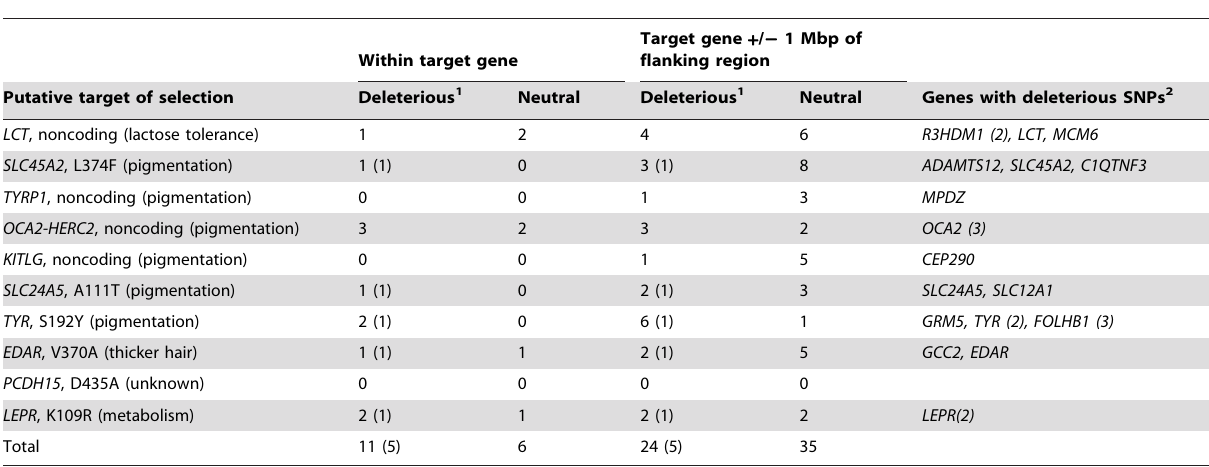
Table 2. Deleterious SNPs within and around genes under positive selection.